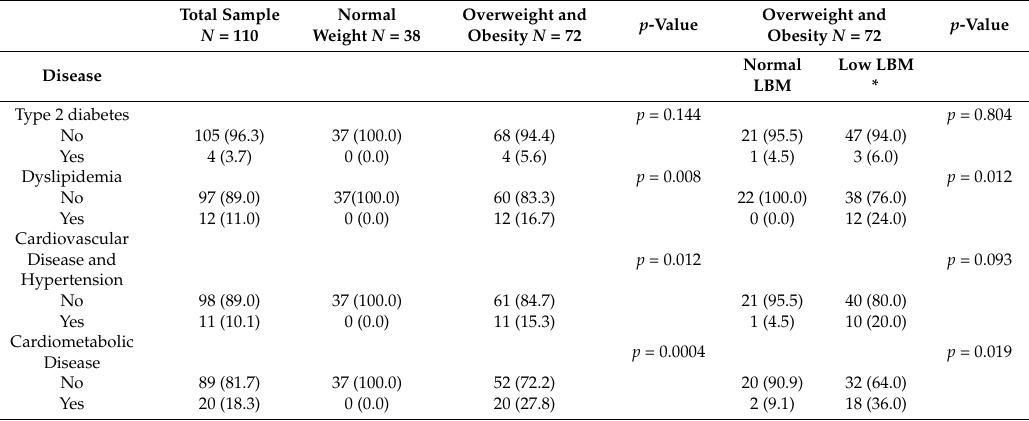
Table 3. Prevalence of cardiometabolic disease among the sample study.